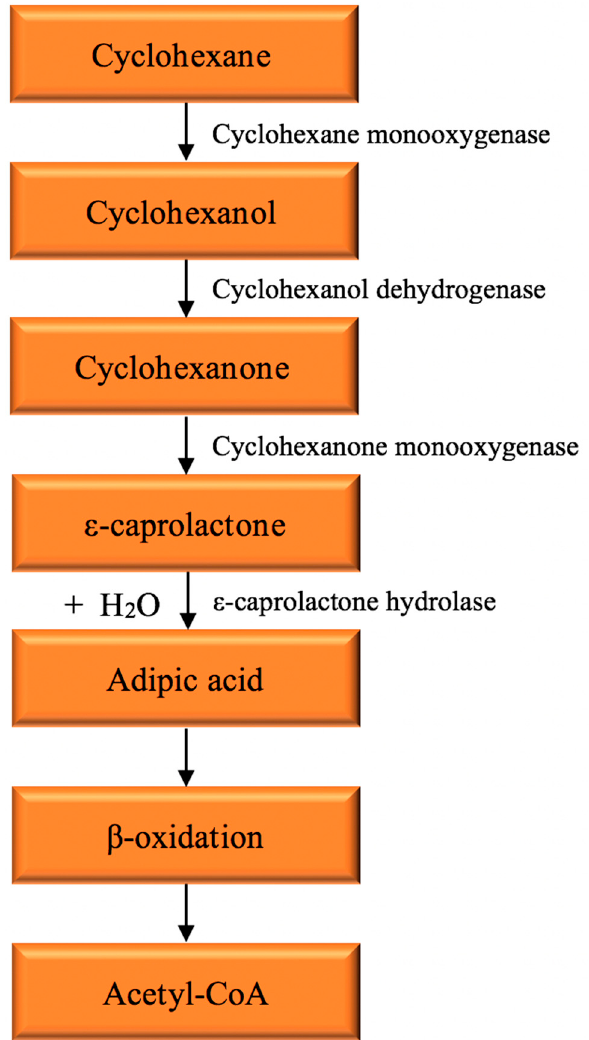
Figure 5. The mechanism of cycloalkane degradation.